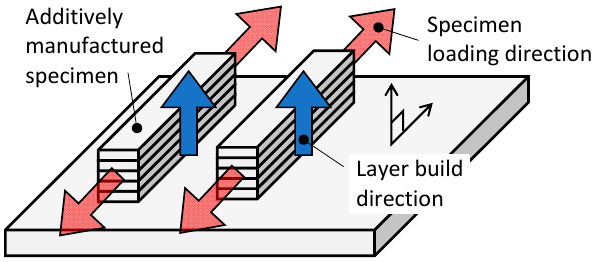
Figure 4. Illustration of specimen build direction relative to the applied loading direction.